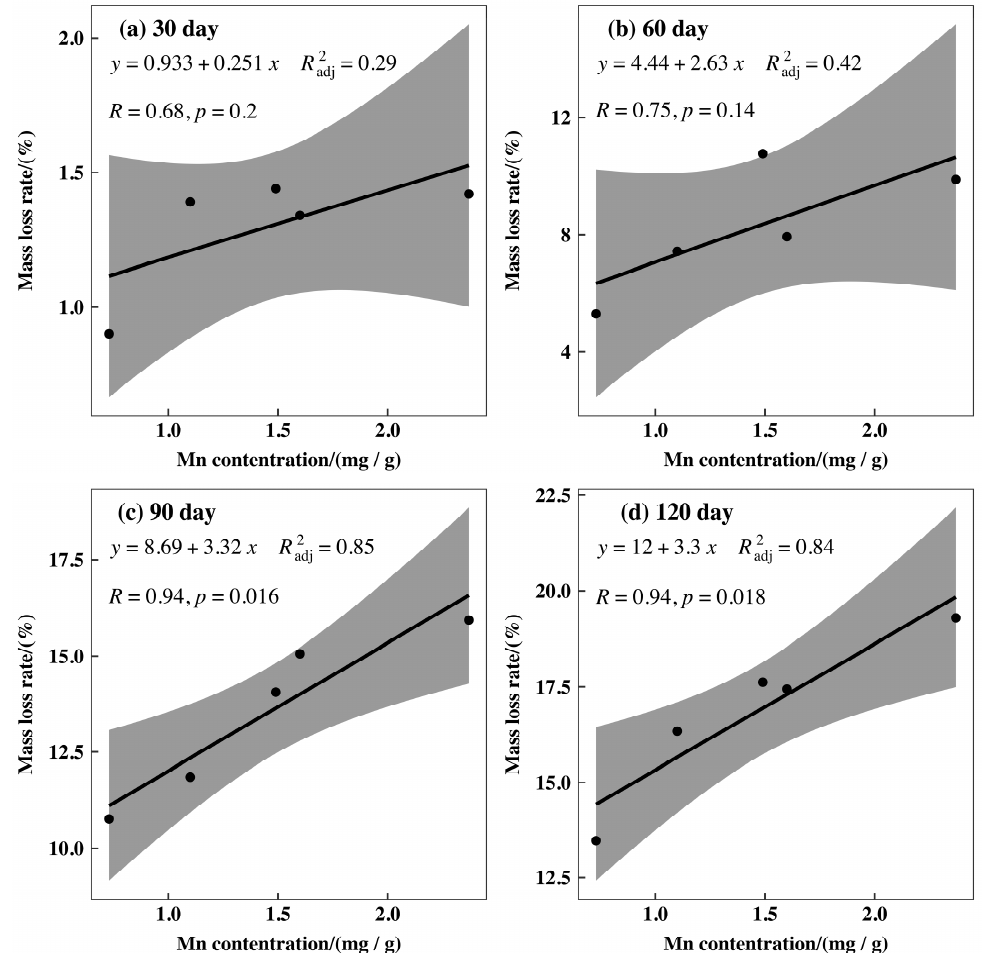
Figure 11. Linear relationships between initial litter Mn concentration and accumulated mass loss for each sampling day. ( a ) The linear relationship between initial litter Mn concentration and ac- cumulated mass loss in 30 days. ( b ) The linear relationship between initial litter Mn concentration and accumulated mass loss in 60 days. ( c ) The linear relationship between initial litter Mn concen- tration and accumulated mass loss in 90 days. ( d ) The linear relationship between initial litter Mn concentration and accumulated mass loss in 120